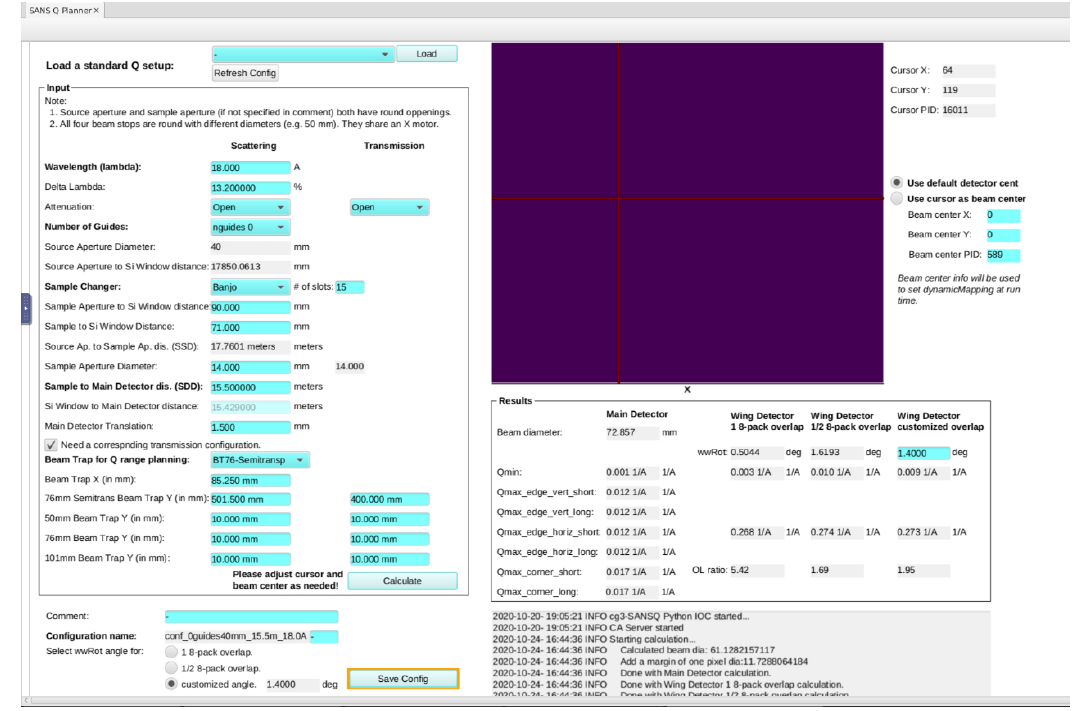
Figure 6. The Q-Range Planner.